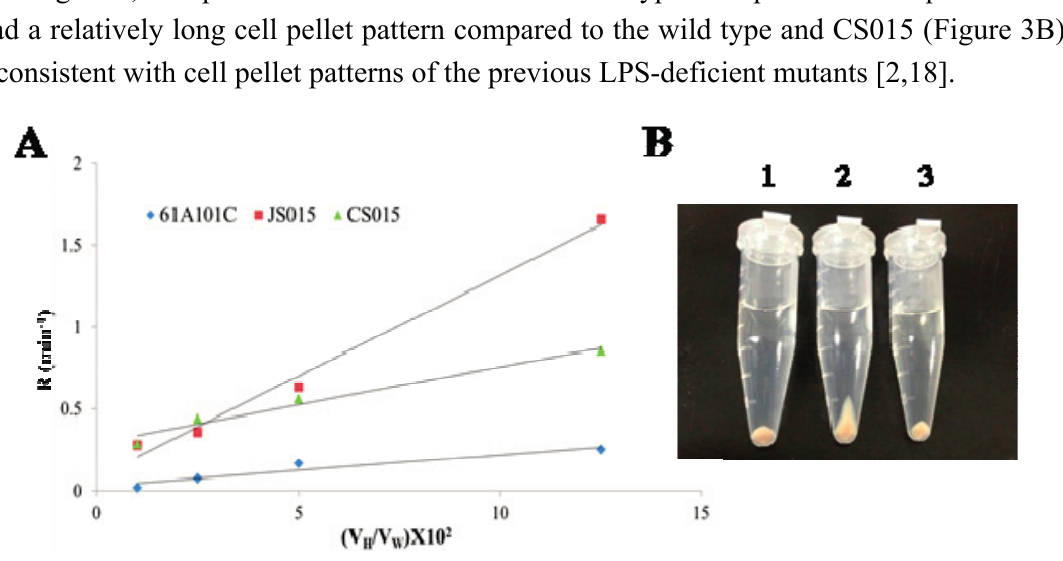
Figure 3. Cell surface hydrophobicity ( A ) and cell pellet pattern ( B ) of three B. japonicum strains: 1, 61A101C; 2, JS015; 3, CS015. ( A ) The x -axis represents removal rate per min